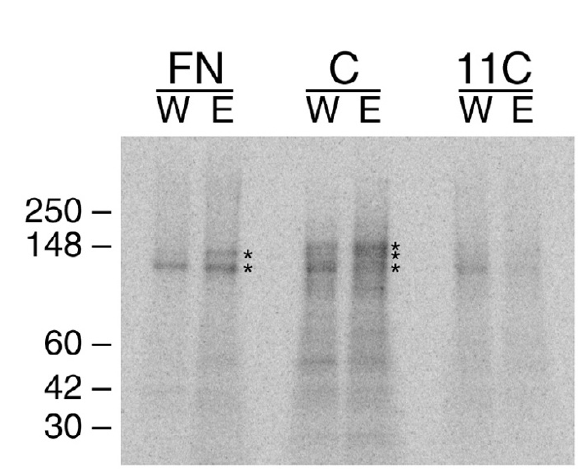
Figure 4 Affinity chromatography of 125 I surface labeled pro- teins on III1-C Sepharose RASMCs were surface labeled with 125 I, lysed in octylglucoside lysis buffer, and these cell lysates were passed over affinity columns containing either FN (FN), III1-C (C), or III 11-C (11C). The columns were washed and bound proteins were eluted with 10 mM EDTA in lysis buffer. Samples from the final wash before elution (W lanes), and from the elution (E lanes) fractions of each col- umn were analyzed by SDS-PAGE and phosphorimager analy- sis. Numbers to the left of the panel indicate the migration of molecular mass markers (kDa). Asterisks mark the positions of bands that bound to and were eluted from the FN and III1- C